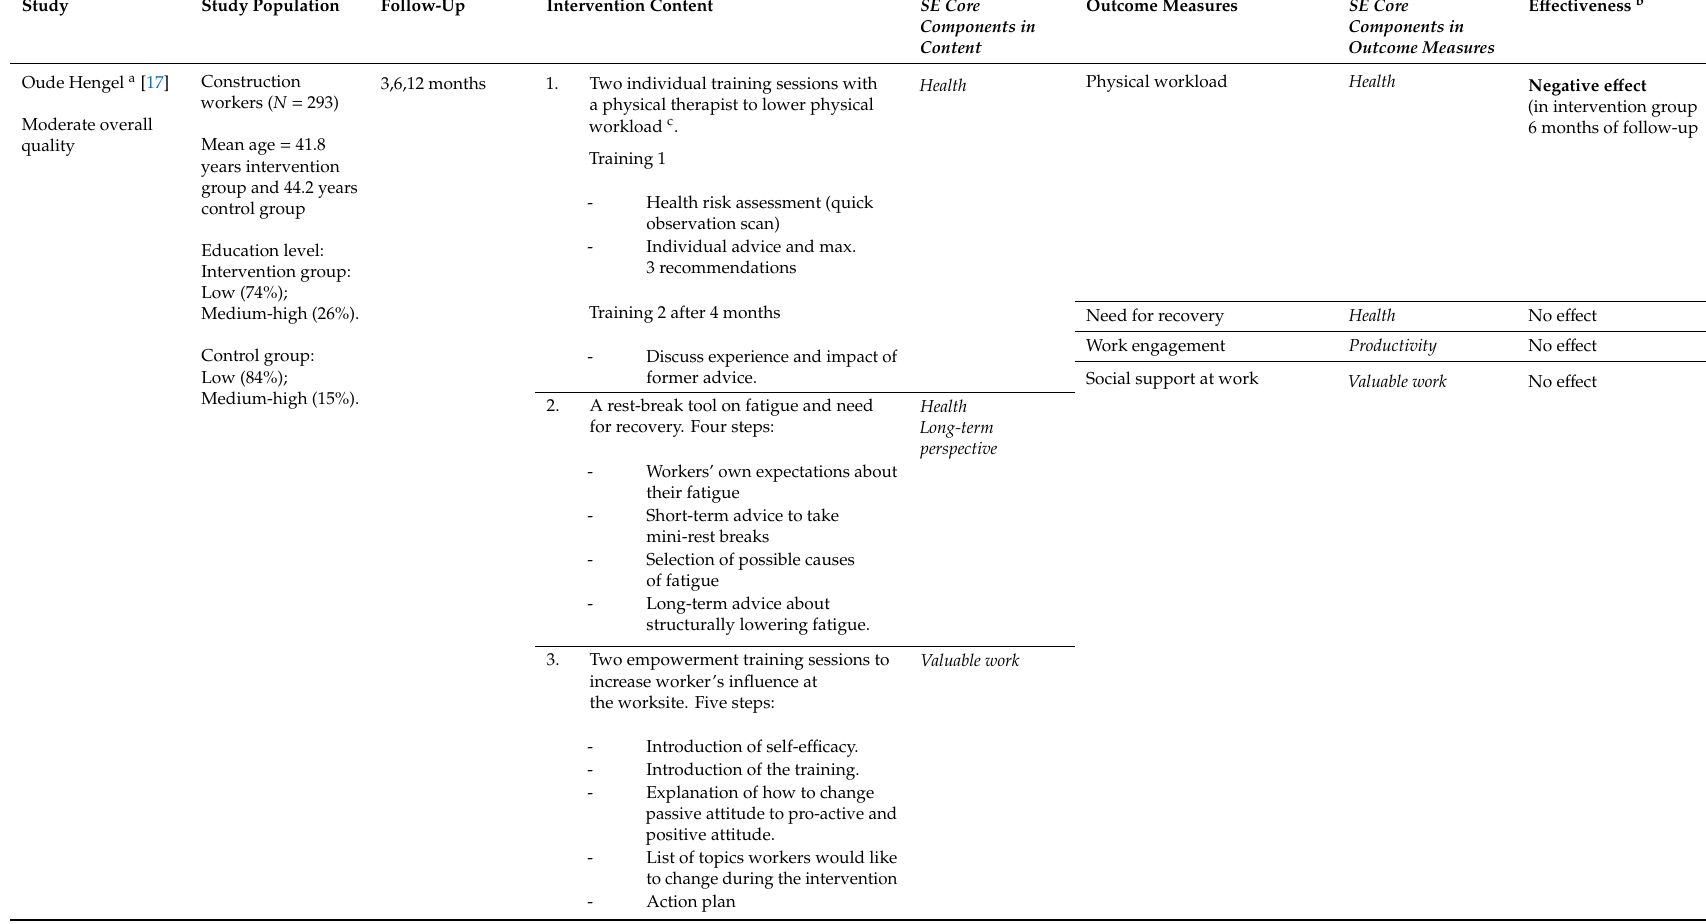
Table 3. Description of interventions, outcome measures and e ff